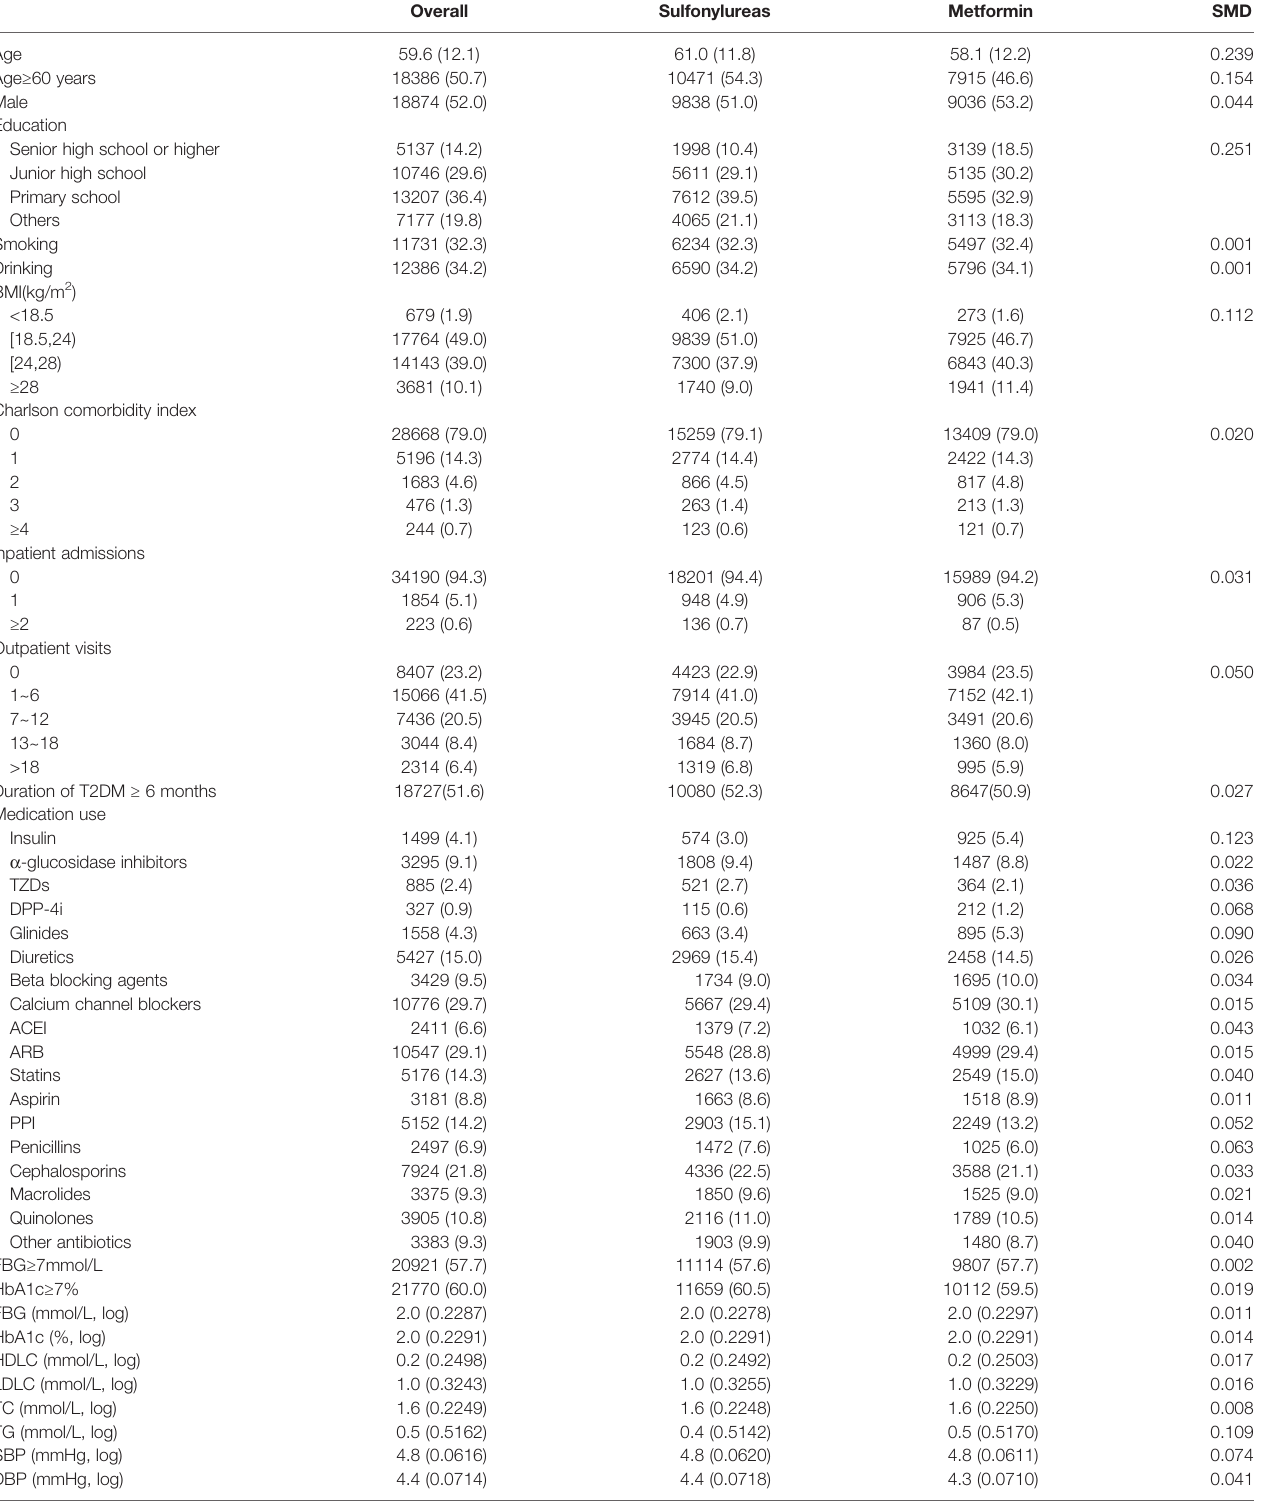
TABLE 1 | Baseline characteristics of participants initiating sulfonylurea and